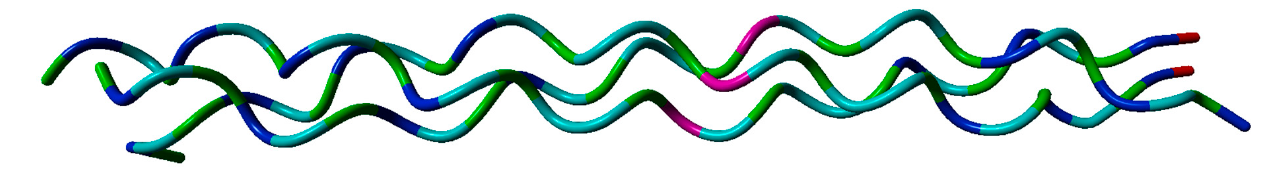
Figure 3. The optimized structure of collagen. ARG, GLY, and HYP amino acids are denoted by pink, dark blue, and green colors, respectively.